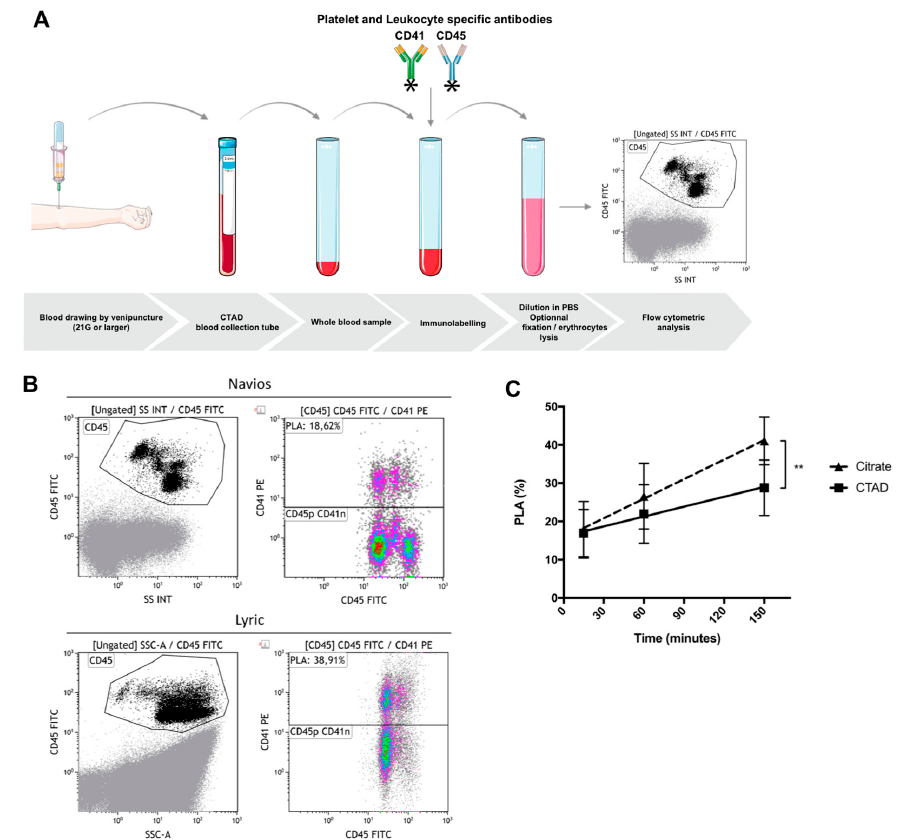
Figure 2. Platelet–leukocyte aggregates (PLAs) analyzed with flow cytometry ( A ). Schematic representation of sample preparation for PLA measurement in whole blood. Venous blood was drawn by puncture of a large vein using a 21-gauge needle and collected into tubes containing CTAD (sodium buffered citrate, theophylline, adenosine, and dipyridamole). The first milliliters were discarded. Blood sample was labeled using antibodies against CD45 and CD41 (20 µL of blood + 20 µL of PBS buffer + 10 µL of each antibody), with fixed incubation time (<1 h), followed by dilution ( ≥ 1/40) in PBS or with lysis and fixation buffer. ( B ) Example of samples acquired on Navios (top) or Lyric (bottom) flow cytometer. Blood was labeled using antibodies against CD45-FITC and CD41-PE, with 15 min of incubation (no lysis, no wash protocol). Final blood dilution was 1:44. Flow rate was at 70 events/sec and 10,000 events were acquired. Leukocytes (CD45) were defined as CD45pos side scatter high [CD45] (left panels). Then PLAs in [CD45] gated dot plots, were identified with the co-expression of CD45 and CD41 (right panels). ( C ) Effect of time prior to immunolabeling on PLAs. Blood was drawn into tubes containing 3.2% buffered sodium citrate or CTAD. Immunolabeling and processing of whole blood samples were performed 15, 60, and 150 min, following blood collection. Blood was labeled using CD45-FITC and CD41-PE antibodies (cf above), without lysis or fixation. Events were acquired on the Lyric system (Becton Dickinson). For every 10 min of time-interval prior to immunolabeling, PLA levels increased by 1.7% (95% CI 1.1 to 2.3, p < 0.0001) in citrate-anticoagulated blood (closed triangles, dashed line) and 0.8% (95% CI 0.2 to 1.4, p = 0.005) in CTAD-anticoagulatedblood(closedsquares, plainline). Linearregressionanalysisdemonstratedareduced rate of in vitro PLA formation, prior to immunolabeling with CTAD (solid line), compared to sodium citrate (dashed line) ( p = 0.037). Data are reported as mean ± SEM ( n = 7). SS INT and SSC-A—side